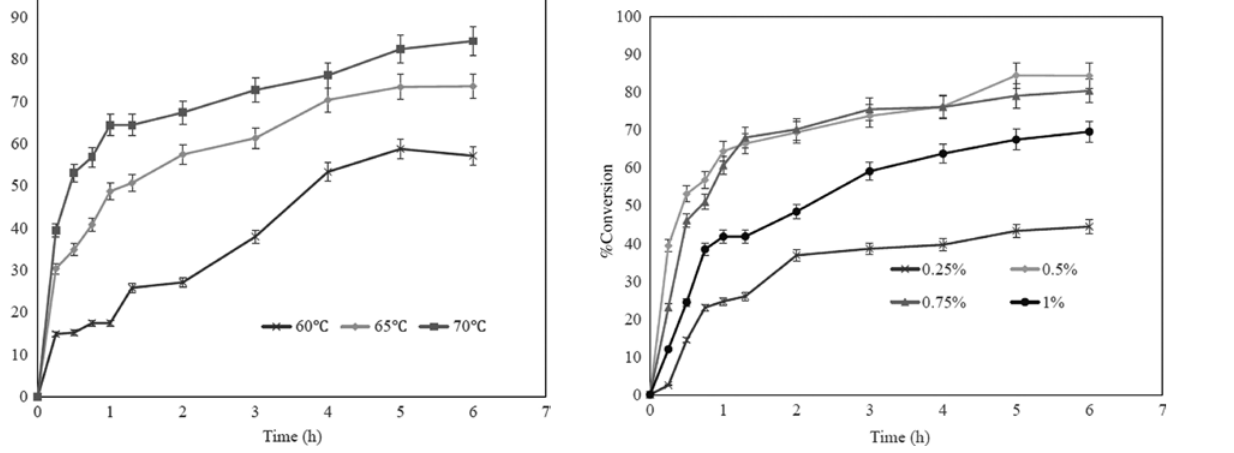
Figure 2: Influence of temperature on reaction conversion at enzyme loading Fermase 0.5% (w/w), stearic acid to PEG 600 ratio 1:4, speed of agitation 200 rpm, and molecular sieves 5%.